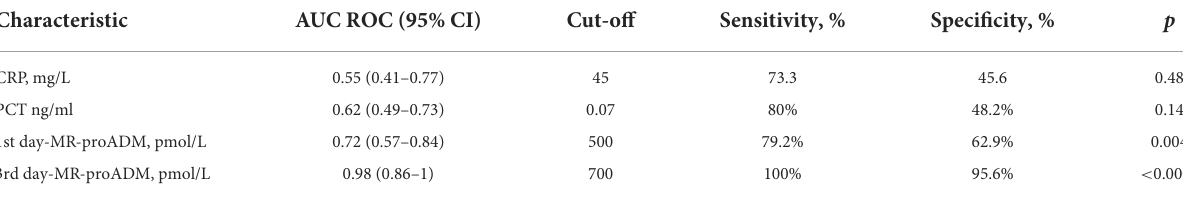
TABLE 3 ROC-analysis results of poor outcome